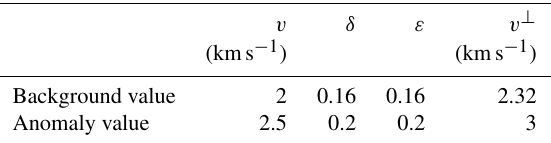
Table 3. For inversion tests, background and anomaly values of all four parameters for the initial/background model and for the anomaly in the target model. The model is a cube of edge 5km. The anomaly is a discretized sphere of 1km in diameter at the center of the